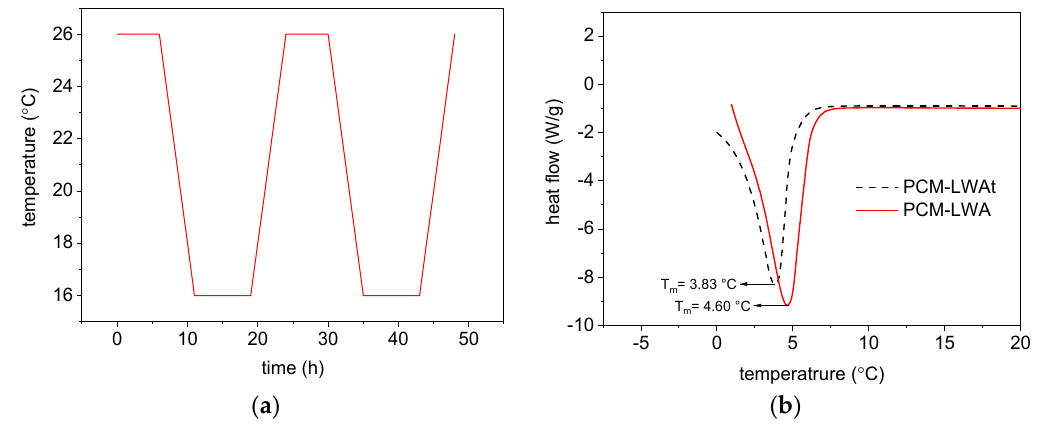
Figure 5. ( a ) Typical 48 h heating and cooling cycle and ( b ) DSC curves of ME-LWA before and after thermal cycling.